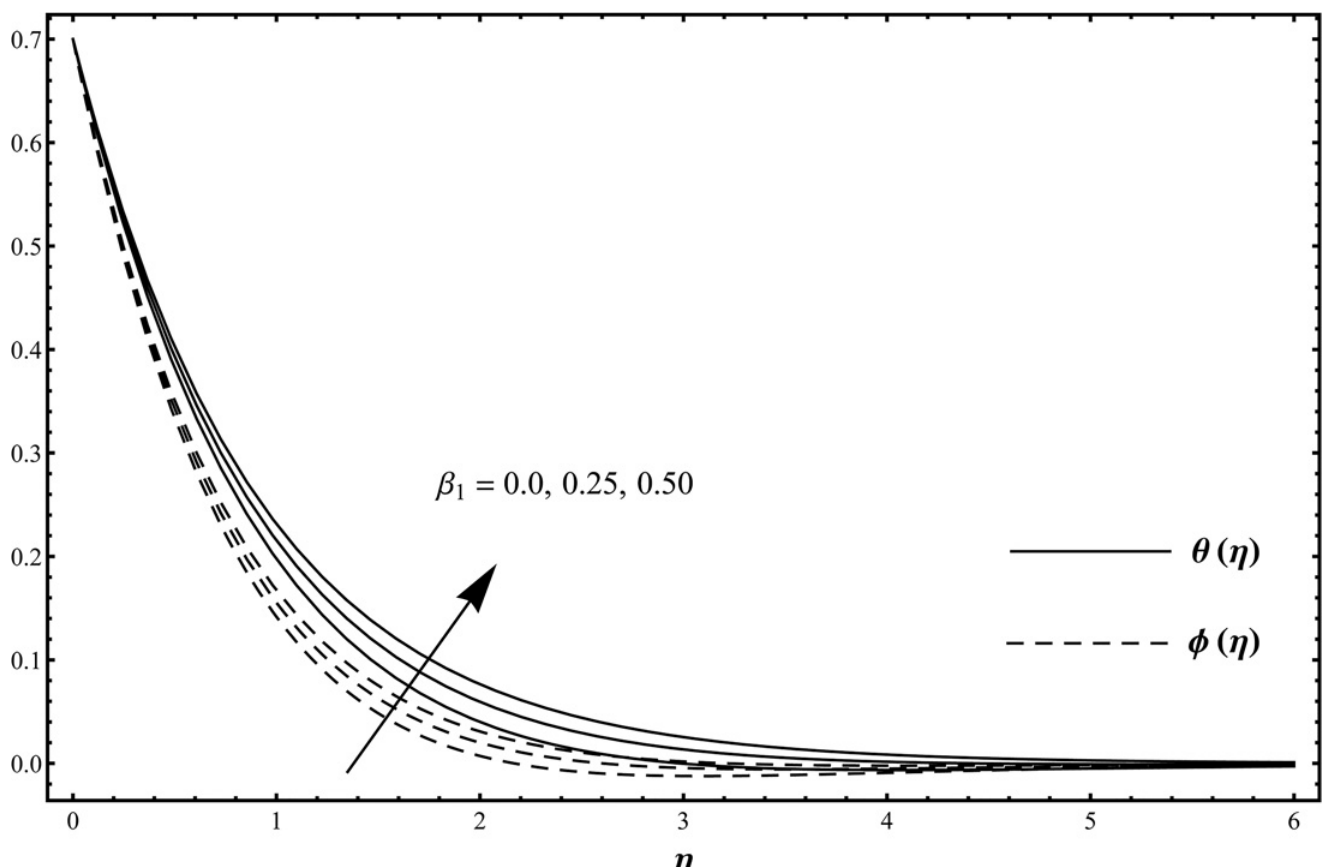
Fig 2. Temperature distribution function θ ( η ) and concentration distribution function ϕ ( η ) when β 1 = 0.0, 0.25, 0.50 and β 2 = 0.2 = γ = Rd , λ = 0.1 = N , Pr = 1.0 = Sc , ε 1 = 0.3 = ε 2